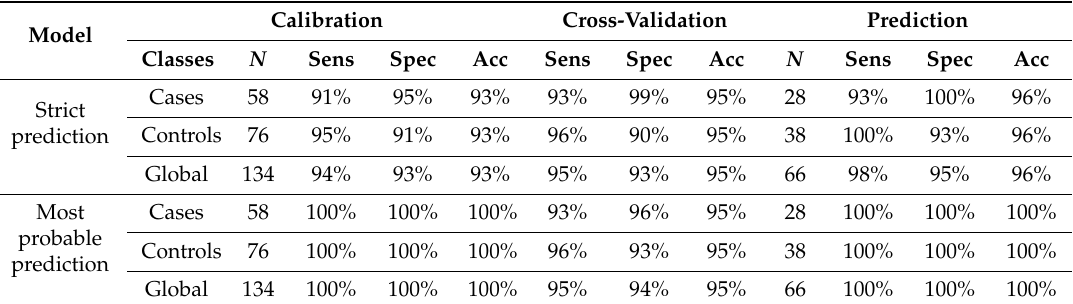
Table 1. Figures of merit for the K-Nearest Neighbors (KNN) model developed for cases vs. controls: sensitivity (Sens), specificity (Spec), and accuracy (Acc) are reported for the strict and the most probable assignation of the